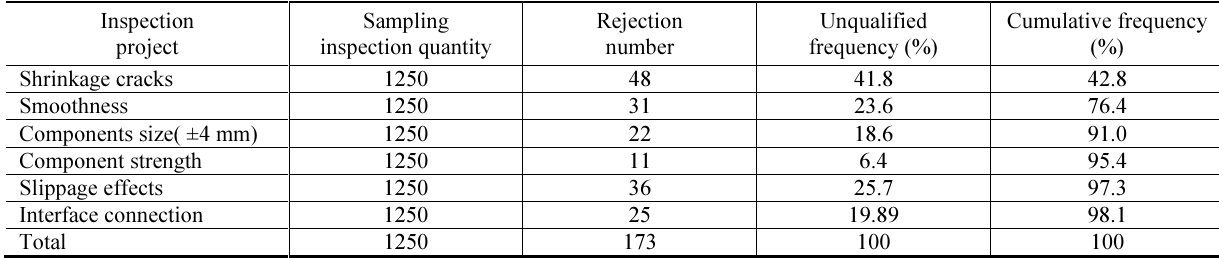
Table 2. Analysis of quality